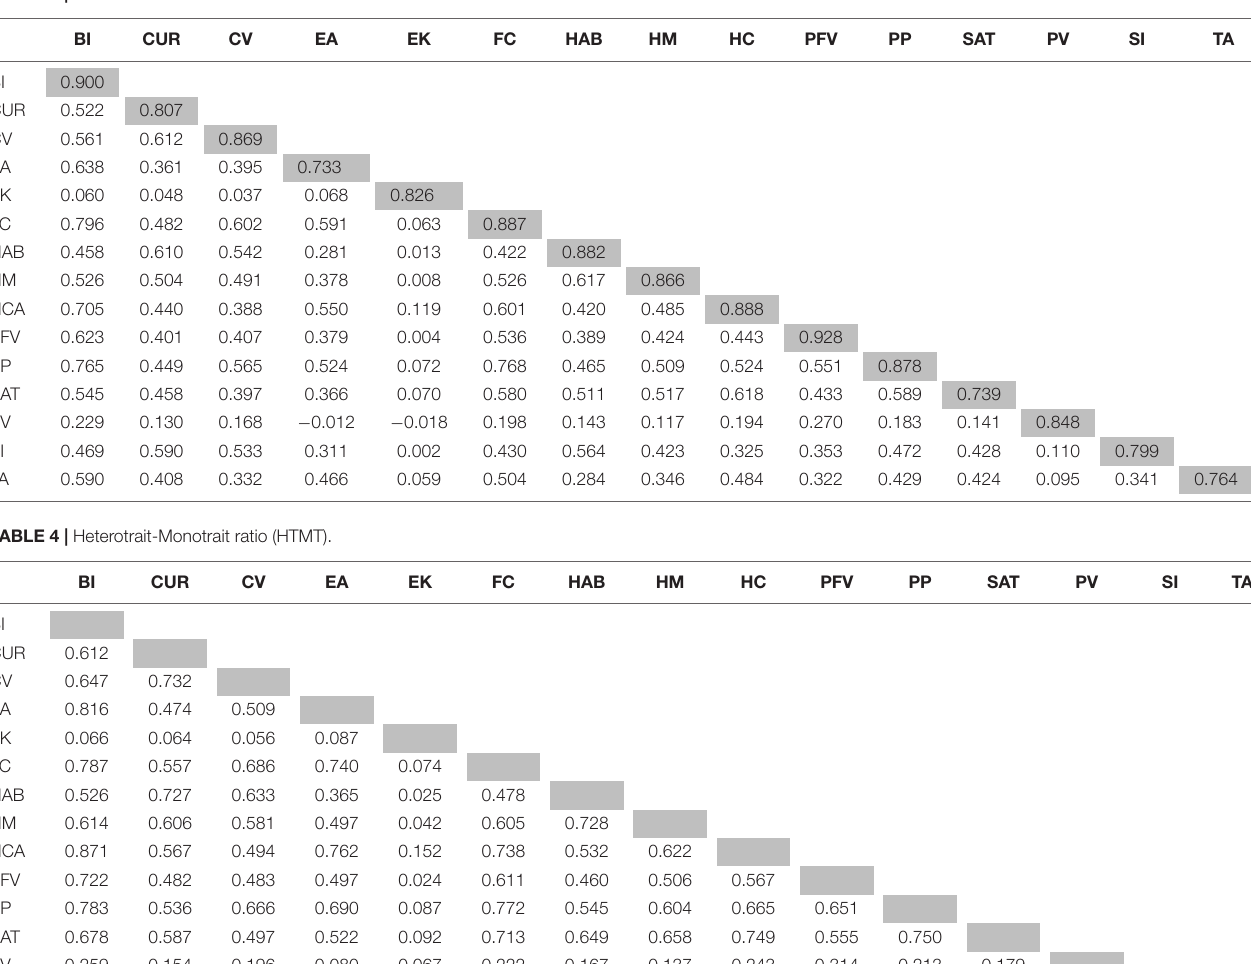
TABLE 3 | Fornell-Larcker criterion.